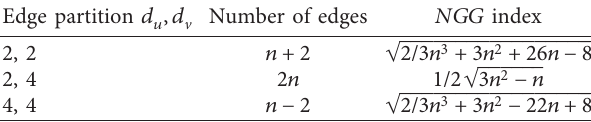
Table 15: Edge partition of ortho chain of n order. Table 16: Edge partition of oxide network of n order.